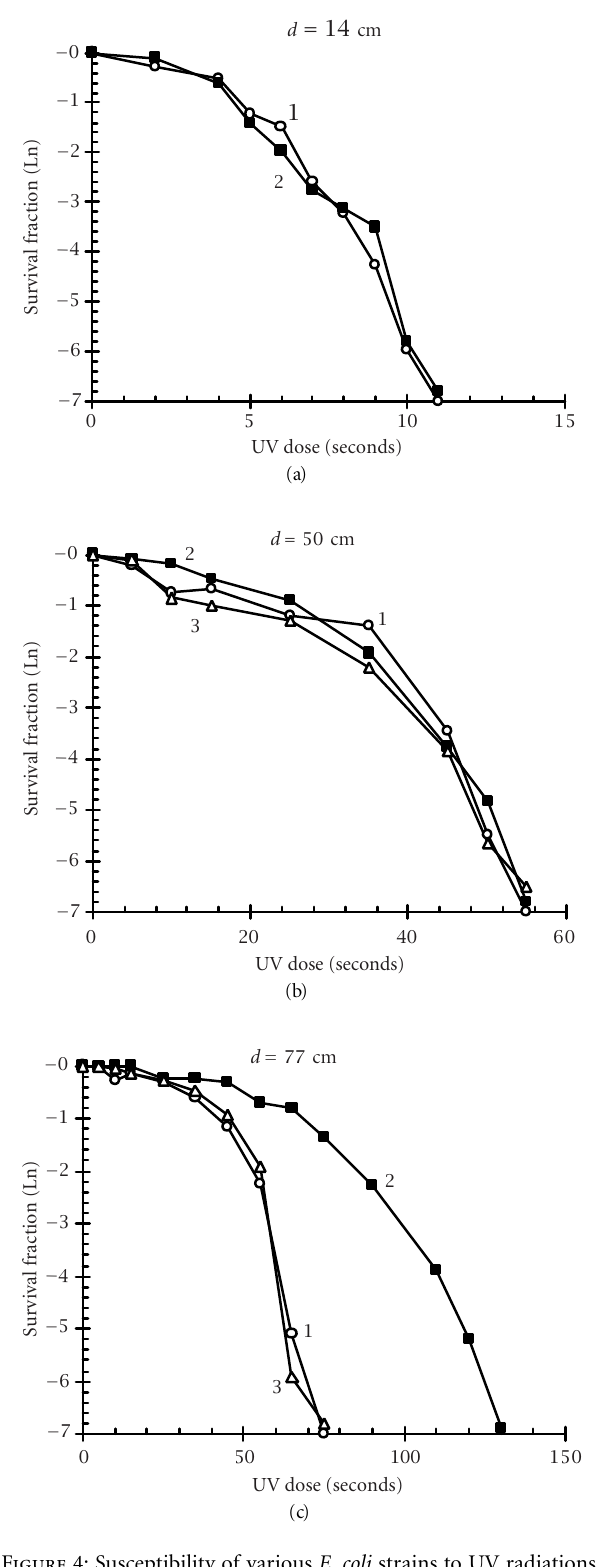
Figure 4: Susceptibility of various E. coli strains to UV radiations. Symbols; 1, E. coli ; 2, E. coli containing pC51 ; 3, E. coli containing pHLD 69 ; d, distance separating the bacterial culture from the UV